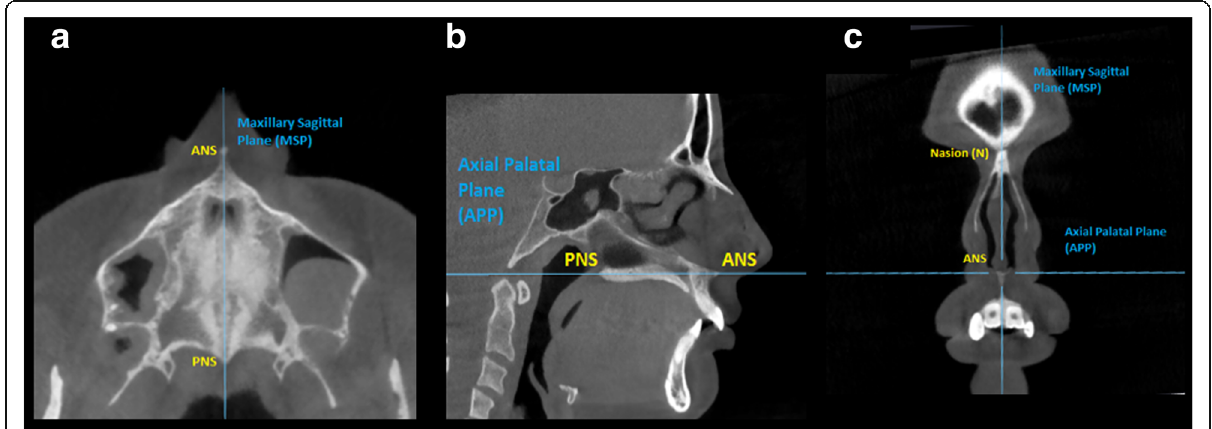
Fig. 4 Sections used to localize the MSP and APP. a Axial section. b Sagittal section. c Coronal section